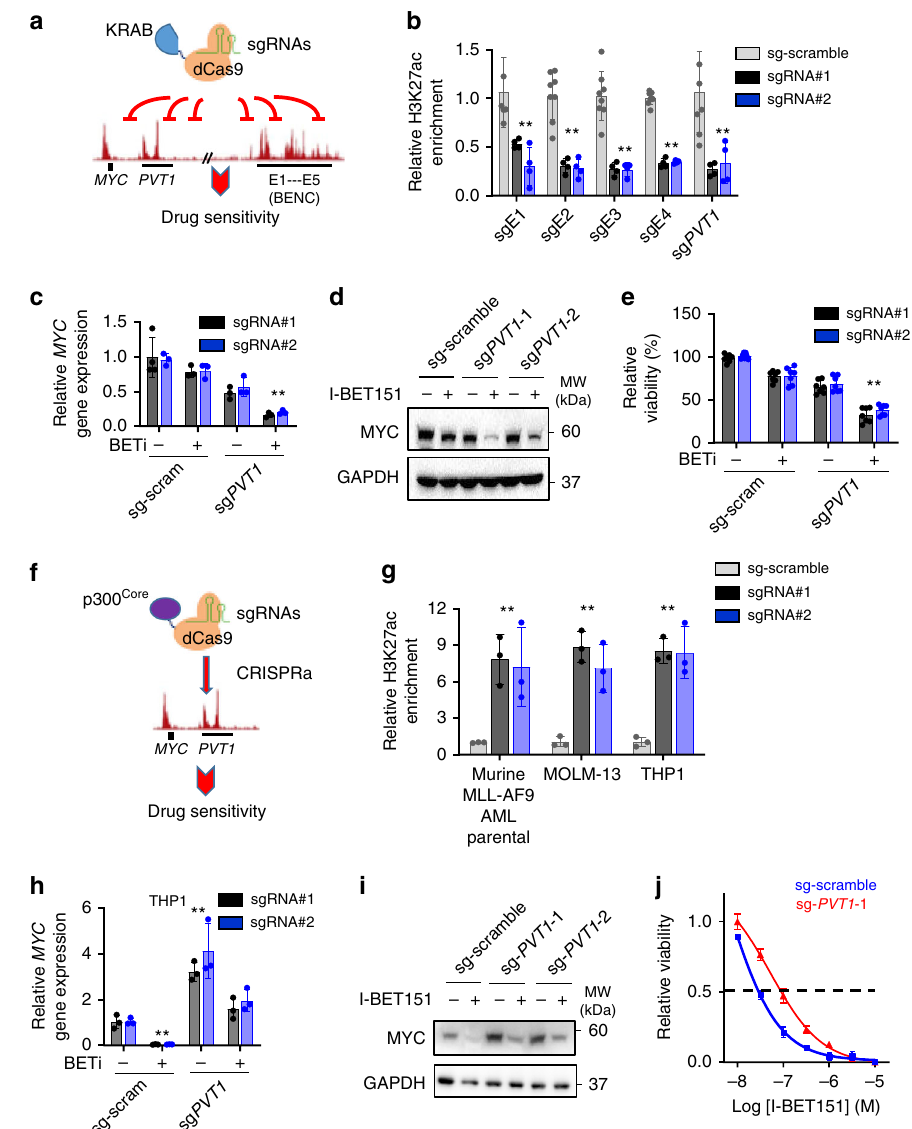
Fig. 6 PVT1 enhancer positively regulates MYC expression in BETi-resistant leukemia cells. a Schematic depicting the use of dCas9-KRAB-based CRISRPi to target MYC-associated PVT1 or BENC enhancers. b ChIP-qPCR analysis of H3K27ac enrichment in K562 cells transduced with a scrambled sgRNA or sgRNA targeted to the PVT1 and BENC loci. Data were shown as mean ± S.D; n = 4 from four independent assays, ** P = 0.01 (E1), 0.0007 (E2), 0.0006 (E3), 0.0001 (E4), and 0.01 (PVT1), by two-tailed Student ’ s t test. c – e Transcription ( c ), protein ( d ) levels and cell viability ( e ) of K562 cells expressing dCas9-KRAB and two independent sgRNAs targeted to PVT1 after BETi treatment. K562 cells transduced with dCas9-KRAB and scrambled sgRNAs were used as control. Data were shown as mean ± S.D; n = 3 from three independent assays, ** P = 0.0002 ( c ) and 0.0004 ( e ), by two-tailed Student ’ s t test. f Schematics depicting the use of the dCas9-p300 Core -based CRISRPa system to target MYC-associated PVT1 enhancers. g ChIP-qPCR analysis of H3K27ac enrichment in THP1, MOLM-13 and murine MLL-AF9 parental cells transduced with a scrambled sgRNA or sgRNA targeted to the PVT1 locus. Data were shown as mean ± S.D; n = 3 from three independent assays, ** P = 0.028 (AF9), 0.012 (MOLM-13) and 0.011 (THP1) by two-tailed Student ’ s t test. h – j Comparison of gene transcription ( h ), protein expression ( i ) levels and dose response curves ( j ) of THP1 cells expressing dCas9- p300 Core and two independent sgRNAs targeted to PVT1 after BETi treatment. THP1 cells transduced with dCas9-p300 Core and scrambled sgRNAs were used as control. Data were shown as mean ± S.D; n = 3 from three independent assays, ** P = 0.0001 (sg-scram) and 0.0005 (sg-PVT1), by two-tailed Student ’ s t